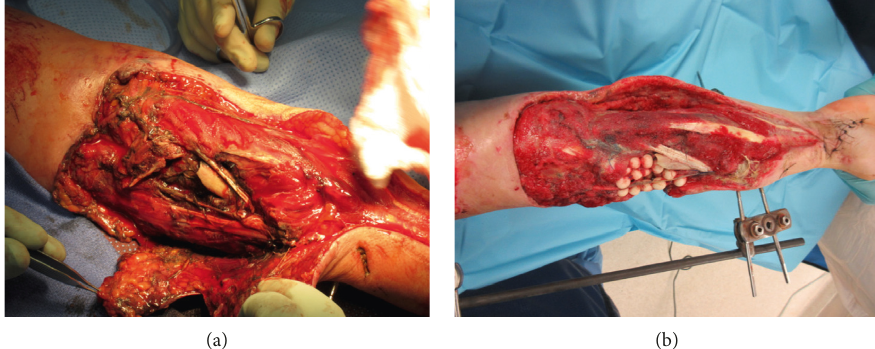
Figure 3: (a) The original debridement with the bony and soft tissue defect. (b) Antibiotic beads in the bony defect on figure fold with external fixator.